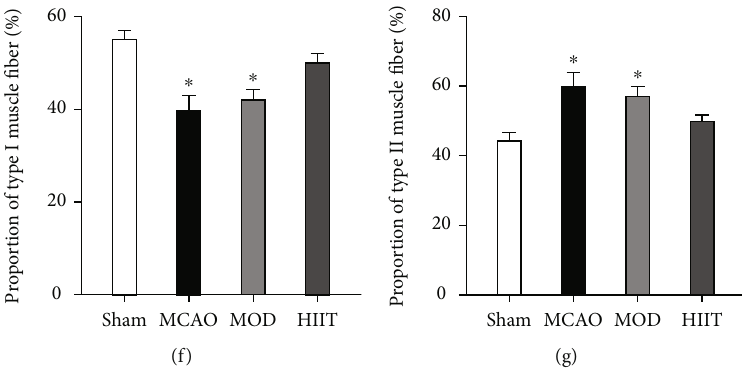
Figure 5: E ff ects of di ff erent exercise protocols on paretic skeletal muscle histopathology. (a) Histological images of HE staining of paretic gastrocnemius muscle tissue in each group (scale bar: 20 μ m). (b) Histological images of ORO staining of paretic gastrocnemius muscle tissue in each group (scale bar: 50 μ m). (c) Representative gastrocnemius ATP-ase staining in each group (type I fi ber: light gray or colorless; type II fi ber: dark gray or black) (scale bar: 50 μ m). (d) Cross-sectional area (CSA) of paretic gastrocnemius muscle fi ber in each group ( n = 5 ). (e) Percentage of lipid accumulation in each group ( n = 5 ). (f) Proportion of type I muscle fi ber in each group. (g) Proportion of type II muscle fi ber in each group ( n = 5 ). Values are expressed as the mean ± SEM of the mean. ∗ P < 0 : 05 and ∗∗ P < 0 : 01 compared with the sham group; # P < 0 : 05 and ## P < 0 : 01 compared with the MCAO group as determined by one-way ANOVA (Tukey ’ s multiple comparison test) for the data with normal distribution. The letters for no signi fi cance were not